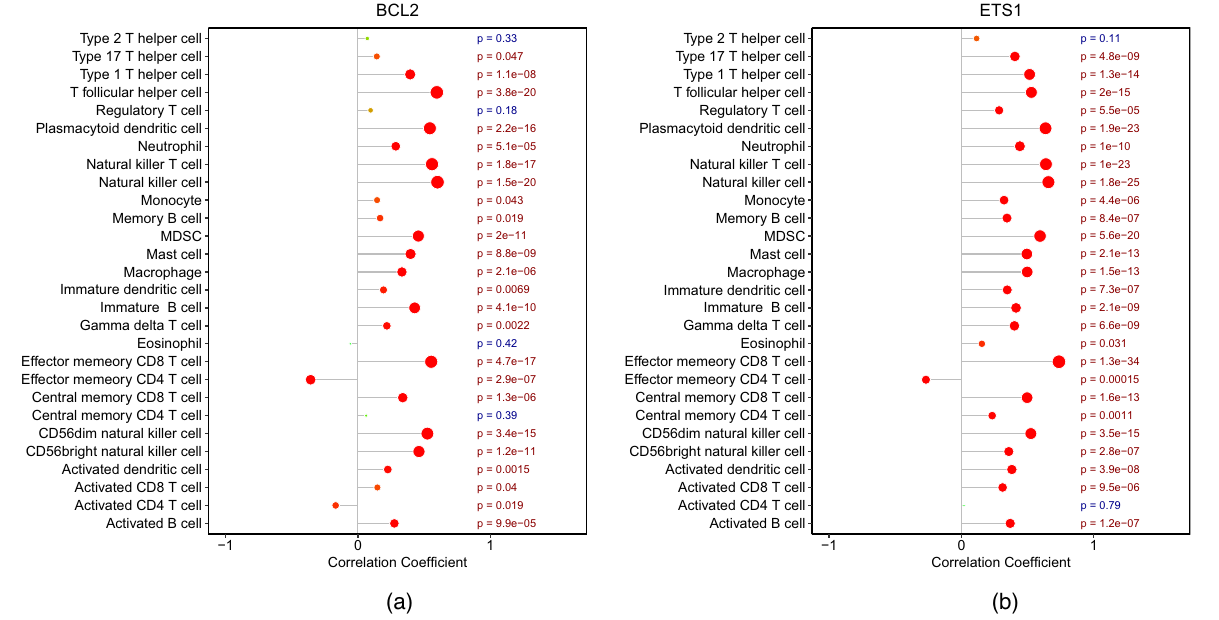
Figure 14. Correlations of immune cell infiltration scores with expression levels of BCL2 and